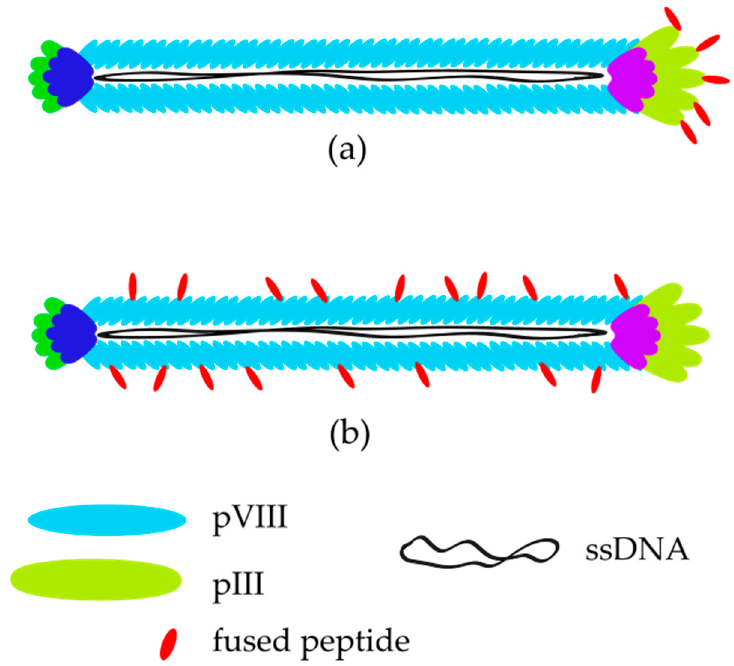
Figure 2. Most common types of phage peptide libraries: ( a ) peptide exposed on N-terminus (outer) of minor coat protein pIII and ( b ) peptide fused into some major coat protein pVIII (landscape library).